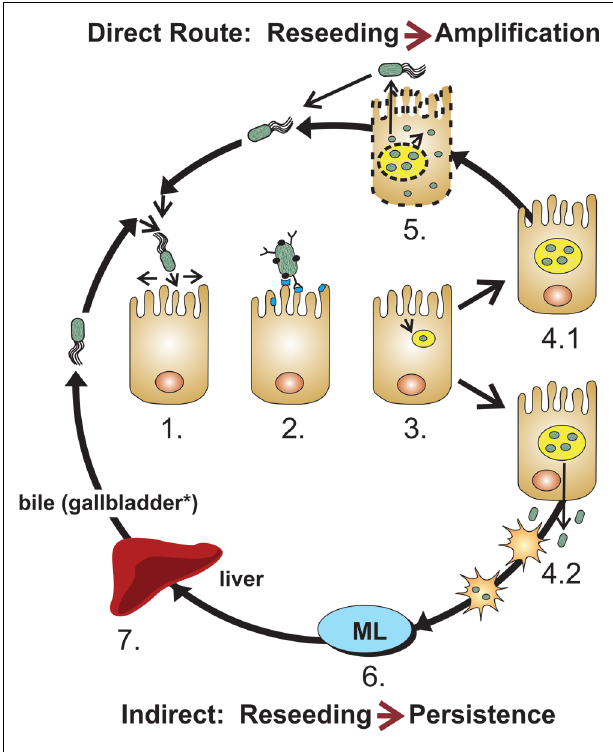
FIGURE 1 | Model of intestinal colonization by Salmonella . Most Salmonella remain associated to specific anatomical segments of the intestines using cyclical multiplication steps in the lumen and enterocytes, using (1) near surface swimming, (2) adhesion (several adhesins), (3) invasion with formation of SCV, (4.1) intravacuolar replication, (5) escape in the cytoplasm, pyroptosis and return to the intestinal surface and lumen. After intravacuolar replication, (4.2) Salmonella can also escape toward the lamina propria, resulting in their potential uptake by dendritic cells and macrophages. (6) Some Salmonella can be further transported to the mesenteric lymph nodes which frequently contain further spreading. Typically for host-restricted (e.g., serovarTyphi in humans) or host-adapted strains (e.g., serovar Dublin in bovines), but also for Salmonella with broad host range encountering stressed hosts or weakened host immune responses, (7) Salmonella can cause bacteremia.When disseminating Salmonella (whether or not host-adapted or restricted) can be somewhat controlled by the host, they typically settle in the liver, gallbladder (for mammals with this organ*), on calculi and in the biliary tract, where they can replicate and be released in the bile to return to the intestines (Oboegbulem and Muogbo, 1981; Cavallini etal., 1991;Wood etal., 1991; Pellegrini-Masini etal., 2004; Akoachere etal., 2009; He etal.,